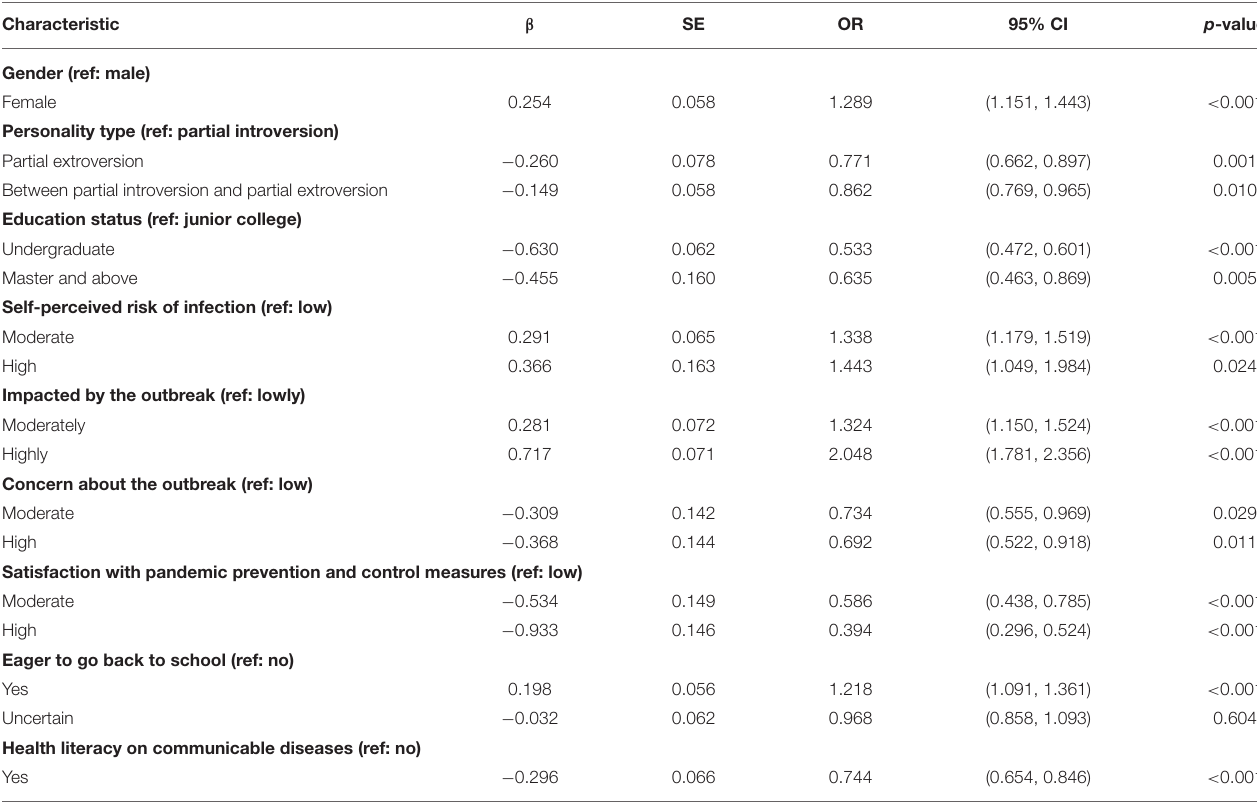
TABLE 2 | Multivariate logistic regression analysis of factors influenced with M/S self-reported depression symptoms. Characteristic β SE OR 95% CI p